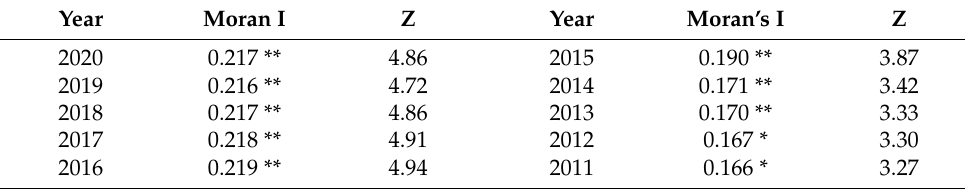
Table 3. Interprovincial innovative ability Moran’s I from 2011 to 2020.